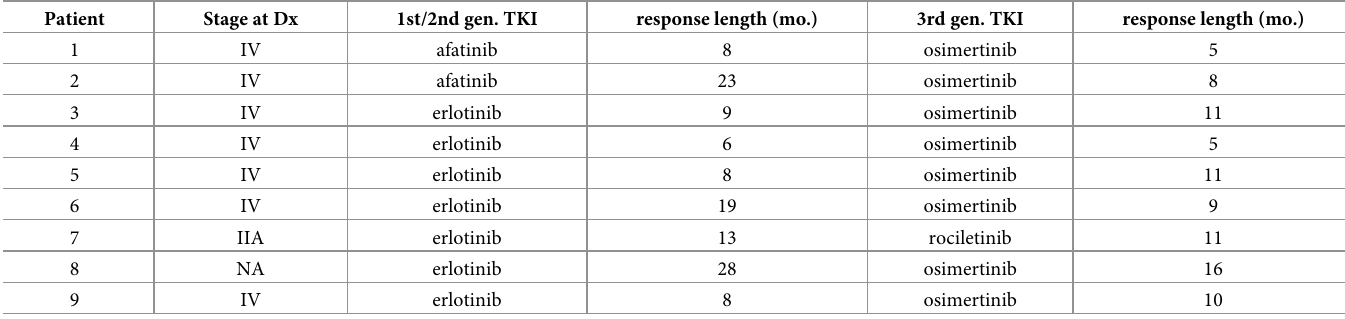
Table 1. Treatment time on EGFR